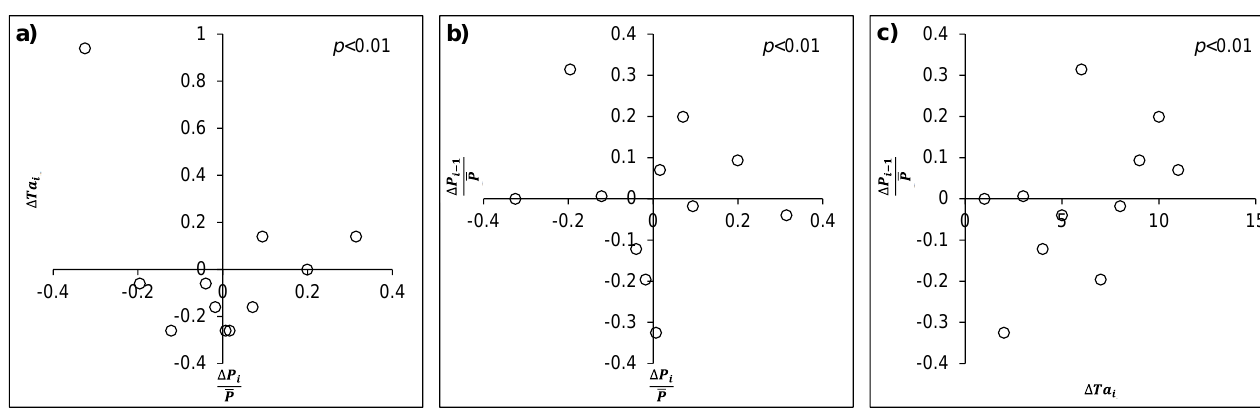
∆ P ∆ P ∆ P ∆ P ; ( b ) ∆𝑃 𝑖−1 ; vs. ∆𝑃 𝑖 ; ( c ) ∆𝑃 𝑖−1 i − 1 i − 1 i i ; ( b ) ; vs. ; ( c ) 𝑃̅ 𝑃̅ 𝑃̅ 𝑃̅ P P P